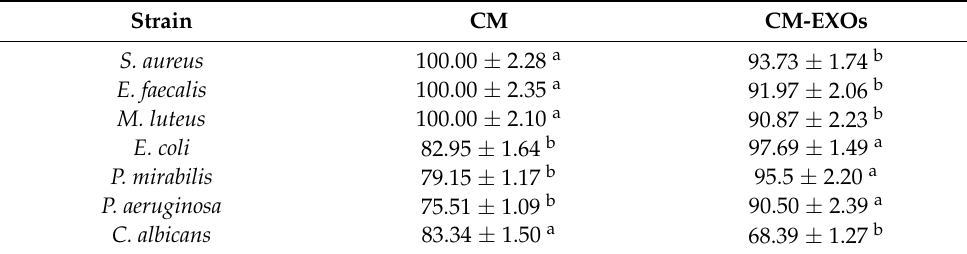
Figure 1. Characterization of EXOs obtained from CM. ( A ) TEM photograph for CM-EXOs, Scale bar = 200 nm. ( B ) The percentage of exosomal CD63 and CD81 protein positivity as determined by flow cytometry analysis. Table 3. CFU reduction (%) of bacterial strain